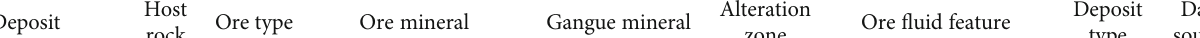
Table 7: Summary of the major features of representative Ag-Pb-Zn deposits in the Xiong ’ er, eastern Qinling-Dabie Orogen.